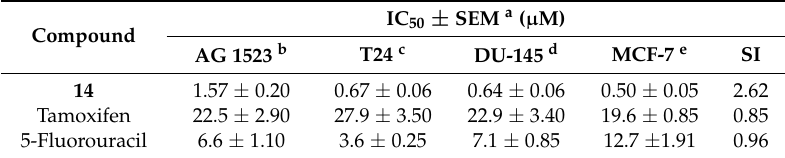
fibroblasts; c T24 (bladder); d DU-145 (prostate); e MCF-7